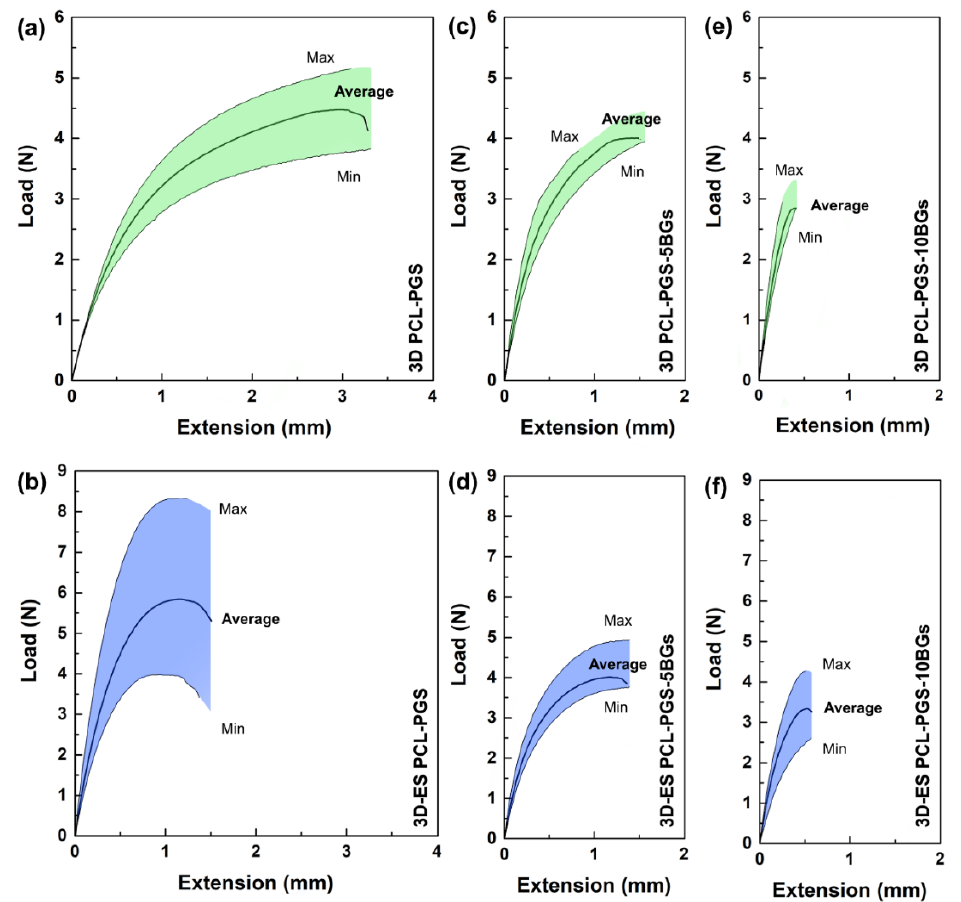
Figure 3. Load vs. extension curves of: 3D printed PCL-PGS, without ( a ) and with ( b ) the electrospun PCL-PGS mat; 3D printed PCL-PGS with 5 wt% of BGs, without ( c ) and with ( d ) the electrospun PCL-PGS mat; 3D printed PCL-PGS with 10 wt% of BGs, without ( e ) and with ( f ) the electrospun PCL-PGS mat. For each sample, the average curve is shown within a shaded region, which indicates the range of load values measured for ten replicates.